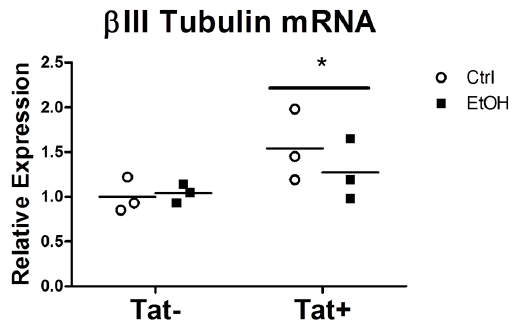
Figure 5. Relative β III tubulin messenger ribonucleic acid (mRNA) expression in control (Ctrl) and EtOH treated NPCs with or without Tat. The solid line indicates the mean of each group. Data were analyzed by two ‐ way ANOVA. N = 3 per group, * indicates p < 0.05 in Tat+ vs Tat ‐ .